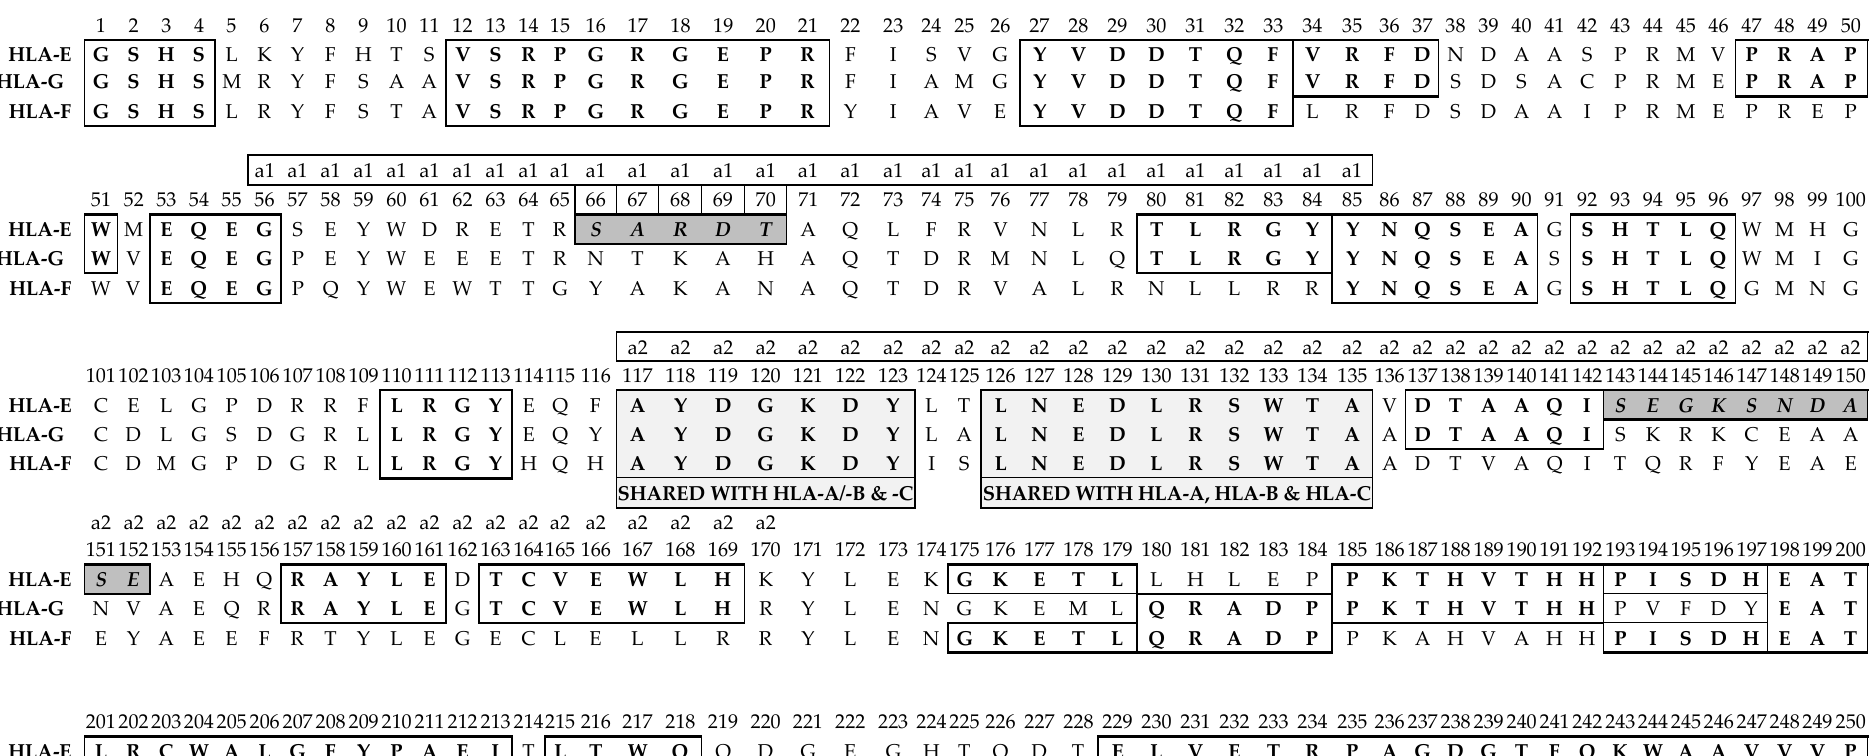
Table 1. Amino acid sequences of HLA-E compared with HLA-F and HLA-G. There are several sequences restricted to HLA-E, as illustrated by a short sequence, 66 SARDT 70 , and a long sequence, 143 SEGKSNDASE 152 . HLA-E shares several sequences with HLA-F and HLA-G. In addition, HLA-E may selectively share several sequences with HLA-G and a few sequences ( 175 GKETL 179 and 193 PISDH 197 ) with HLA-F. Above all, HLA-E shares 117 AYDGKDY 123 and 126 LNEDLRSWTA 135 with all other HLA isoforms (HLA-A, HLA-B, HLA-C, HLA-F, and HLA-G).